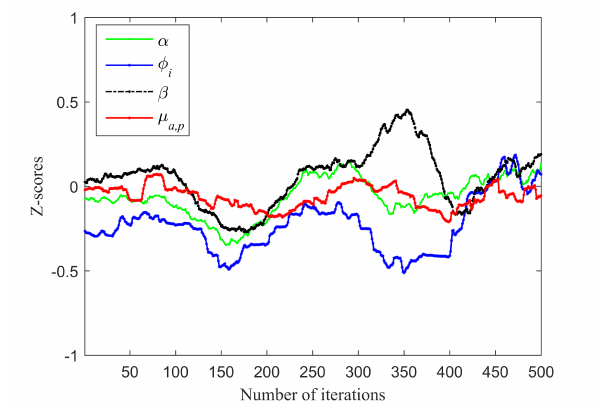
Figure 5. The BHBB framework for failure evaluation of